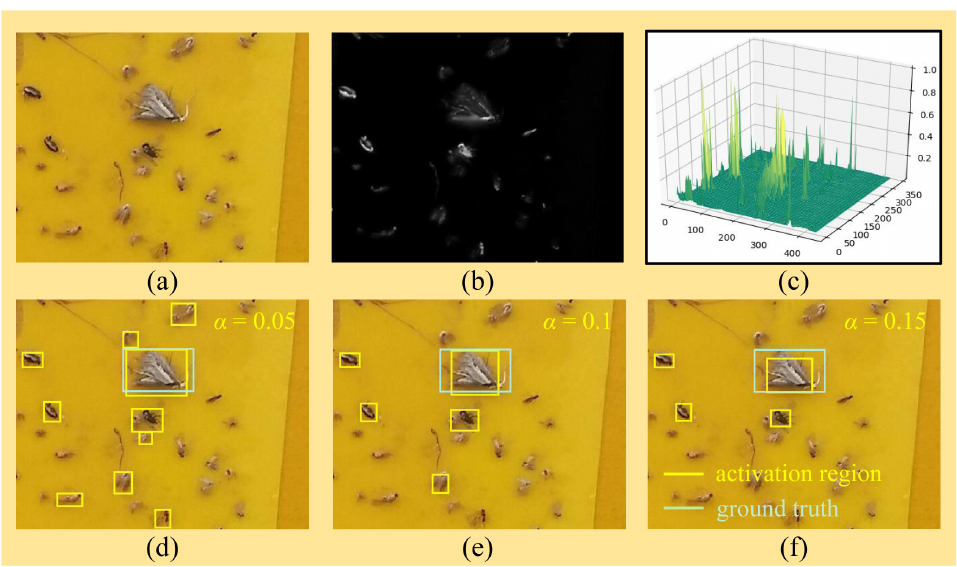
Figure 3. An example of a saliency map. ( a ) The original image; ( b ) the saliency map; ( c ) the three- dimensional diagram, where the z-axis denotes the saliency score; and ( d – f ) the saliency map with α = 0.05, 0.1, and 0.15,